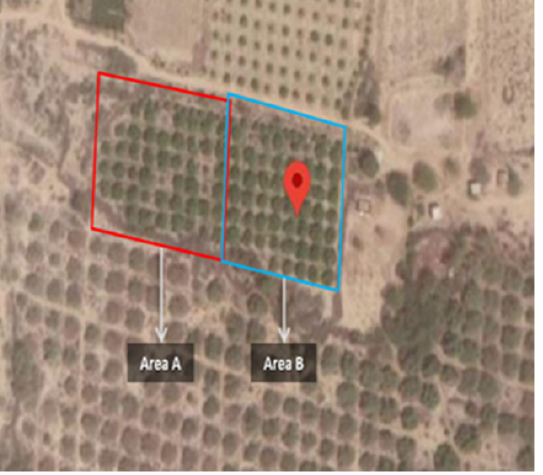
Figure 1. Area A for farmer estimations (2 acres); Area B for agriculture DSS recommendations (2 acres.